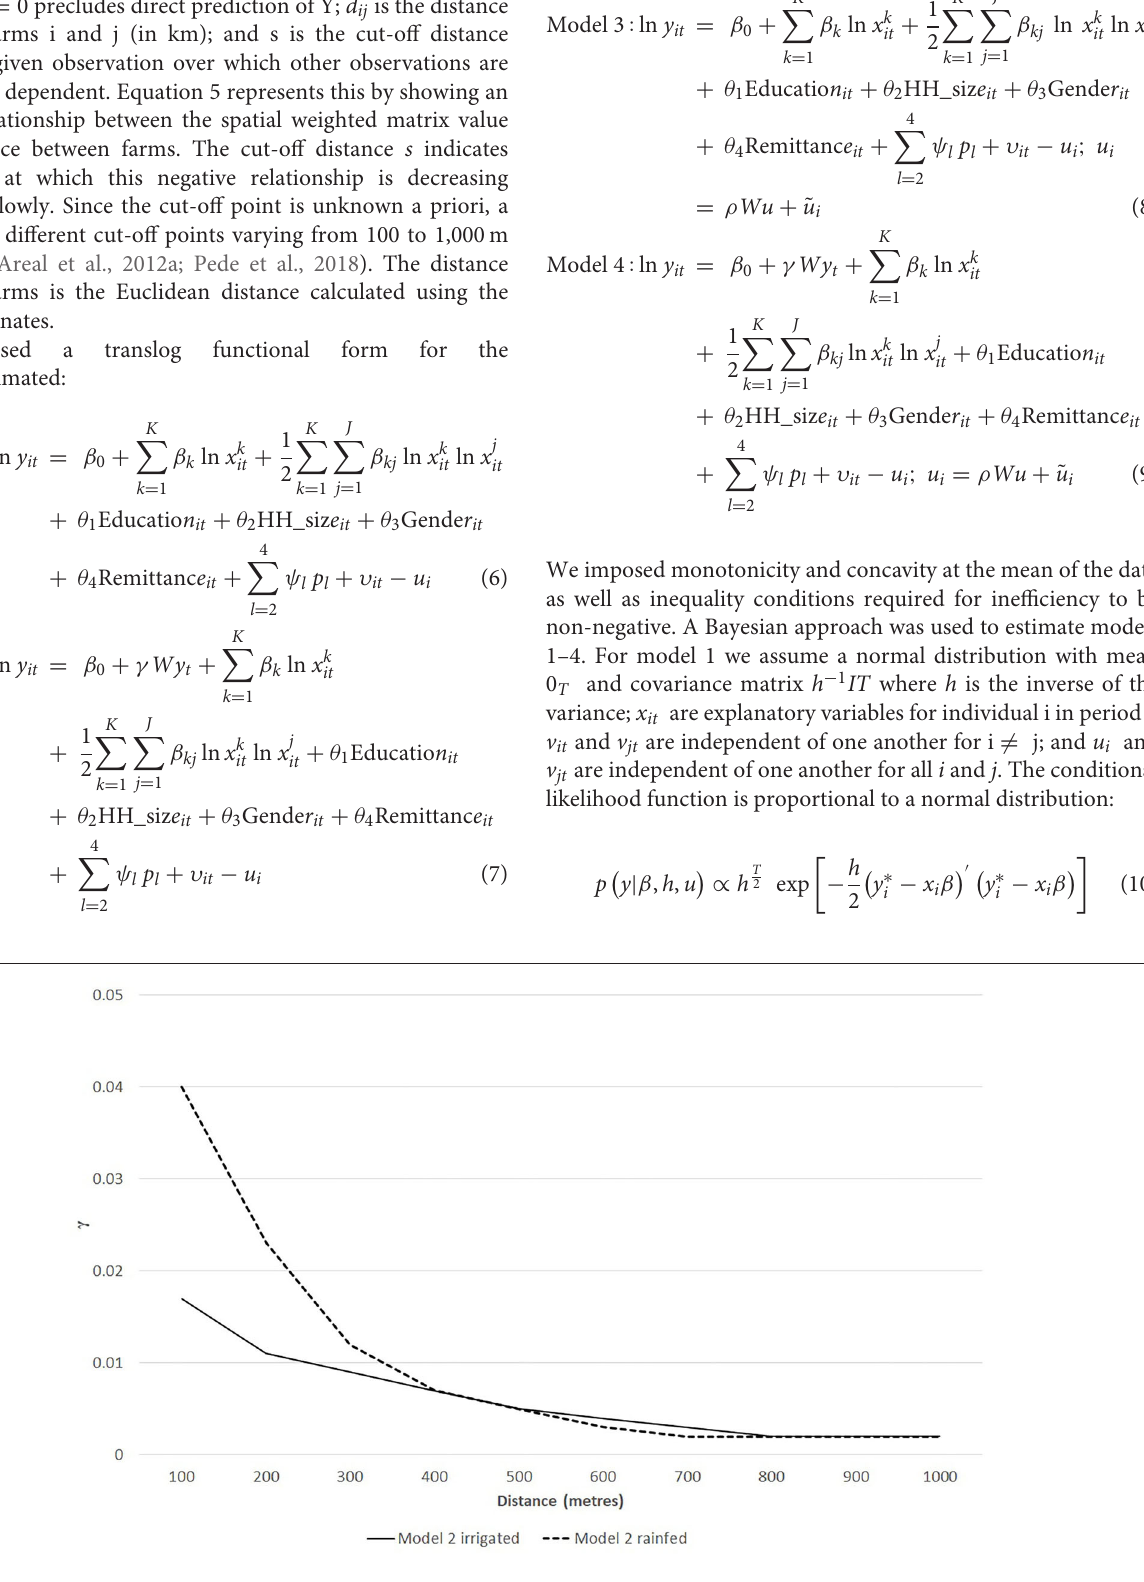
FIGURE 1 | Spatial dependence at different cut-off distances for model 2 in irrigated farms and rainfed farms.